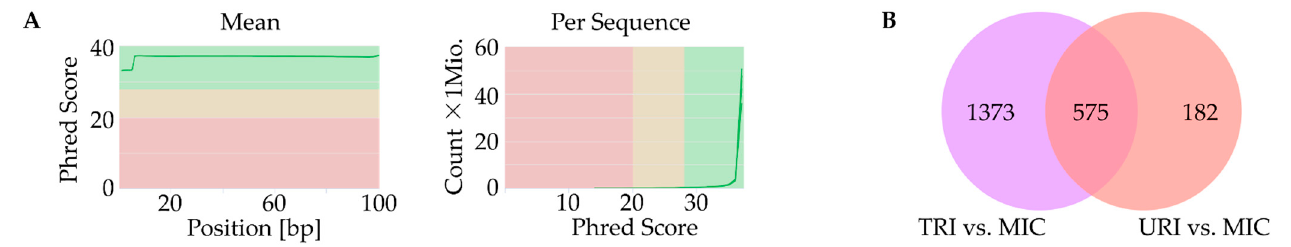
Figure 4. Identification of affected genes. Quality control with high Phred Score for all samples (green-good quality, yellow-mediocre quality, red-bad quality); ( A ); Venn-diagram with upregulated genes of TRI and URI compared to MIC as well as overlap of genes highly upregulated in TRI and URI ( q ≤ 0.05); ( B ). URI, untreated re-infarction; TRI, stem cell treated re-infarction; MIC, MI control.